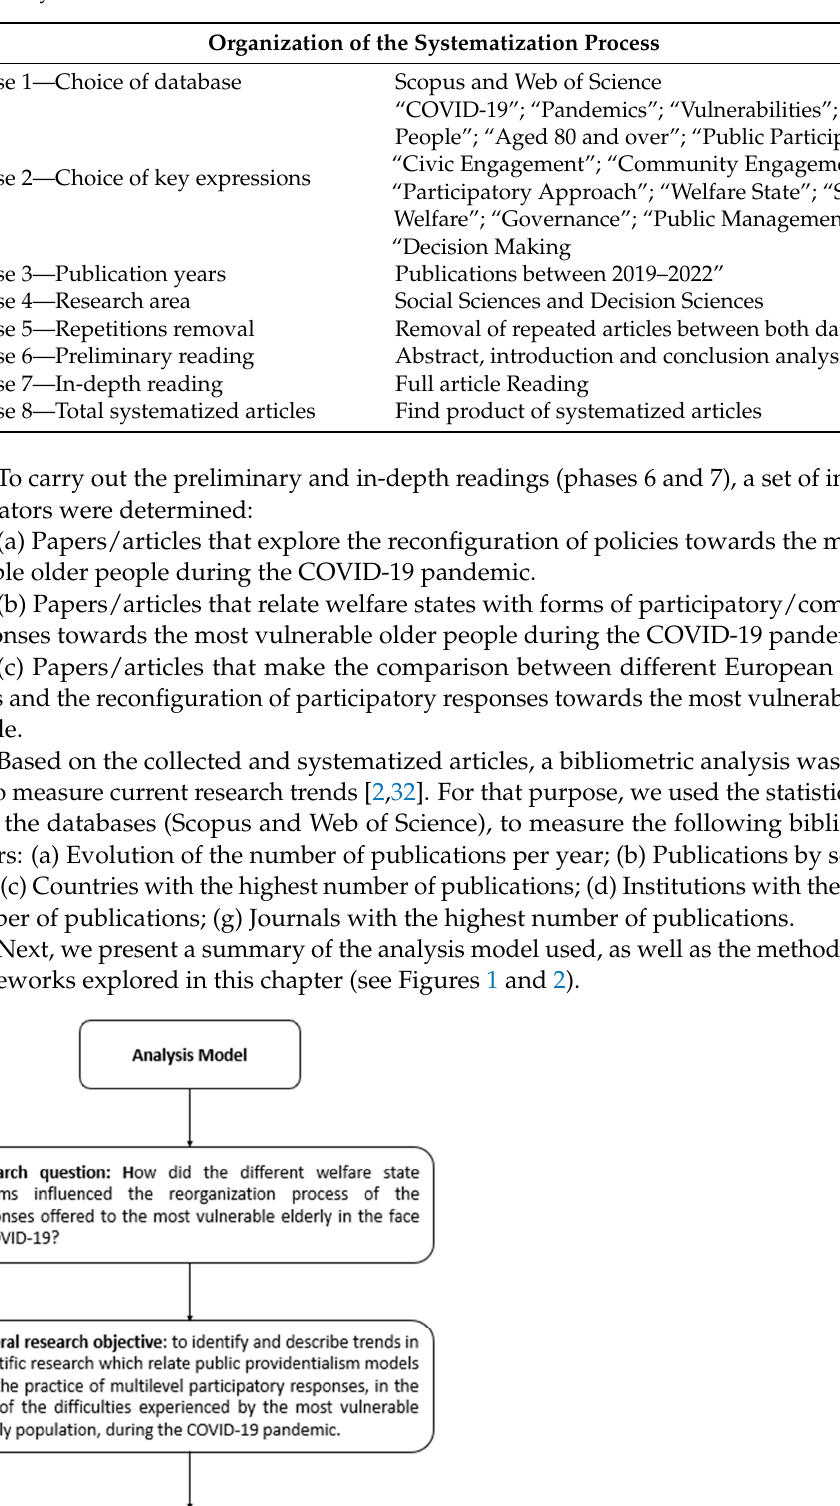
Table 1. Systematization Process.